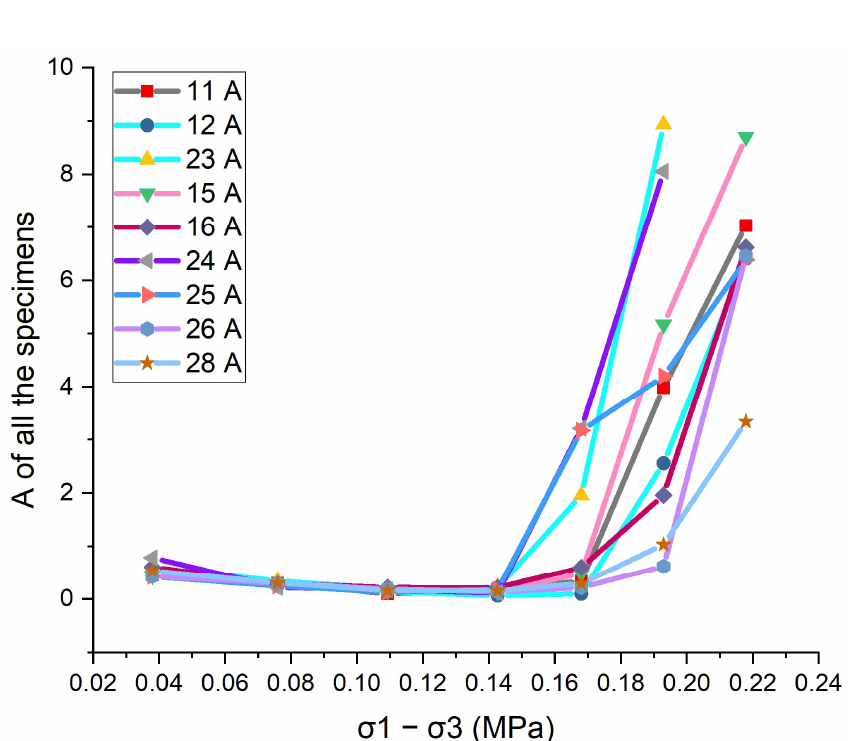
Figure 33. The correlations between A and ( σ 1 − σ 3 ) of all the specimens. From Figure 33, as evidenced, the correlation between A and ( σ 1 − σ 3 ) of all the speci- mens varies little before 0.14268 MPa confining pressure. From 0.14268 MPa, specimens pro- duce evident bifurcation of A . The A of most specimens sharply increases from 0.168 MPa but already differs from 0.14268 Mpa. So, from the tendency distinction, 0.14268 MPa actually should be the σ s of most specimens. Compared with other specimens, the A values of No. 23, 24 and 25 show different variation, which may result from the speci- mens’ preparation because the small disparity in the initial silt-to-clay ratio will affect the compressibility [32]. However, in general, excluding these three specimens, the specimens experiencing 11 FTHs (No. 26, 28) present a wider ADS range in the yield stage than those experiencing 4 (No. 11, 12) and 7 FTHs (No. 15, 16).